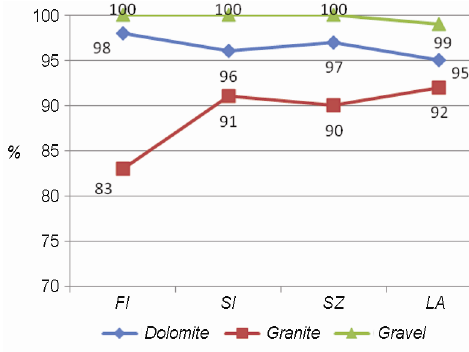
Fig. 4. Summary of results that comply with TRA MIN 07 (2007)